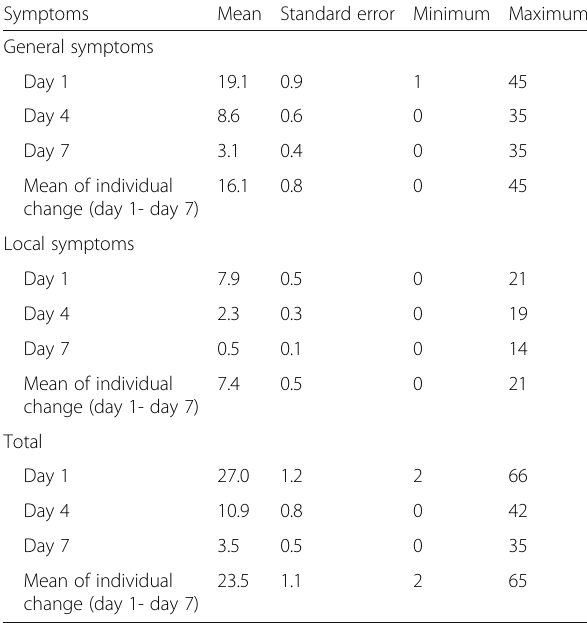
Table 1 Mean symptoms ’ scores over the observation period Symptoms Mean Standard error Minimum Maximum General